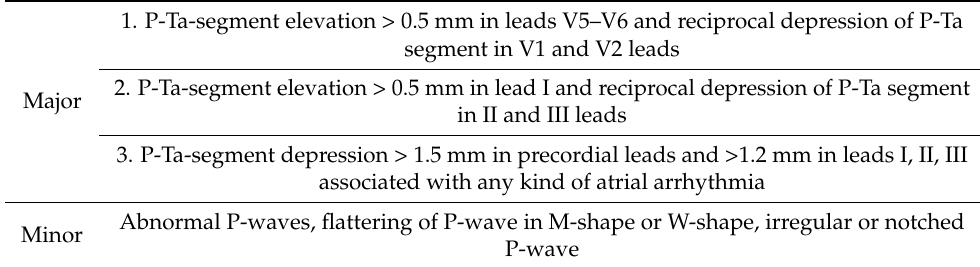
Table 1. Electrocardiographic diagnostic criteria for atrial infarction based on Liu et al. [10].